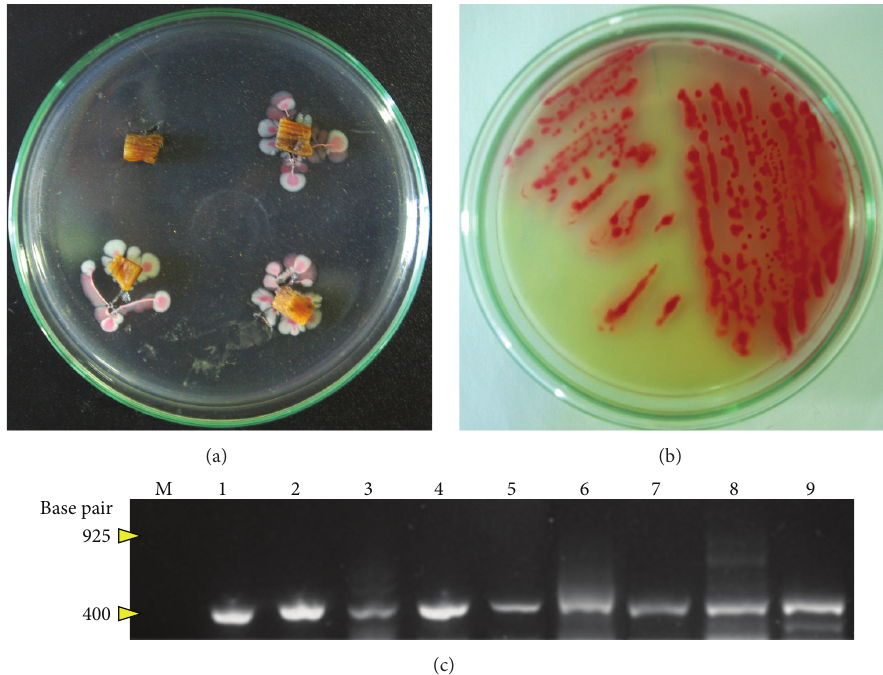
Figure 3: Morphological colonies of bacterial wilt pathogen grew around infected stem (a) and after purification of colony on CPG containing 0.01%TZC(b)whichwasdetectedbyPCRusingFliCprimer(c).LaneM: 𝜆 /StyI;Lanes2–9werebasedonisolatefromSukodono,Pasrujambe, Tempeh 1, Kedung Jajang, Tekung, Yosowilangun, Tempeh 2, Randu Agung 1, and Randu Agung 2, respectively.